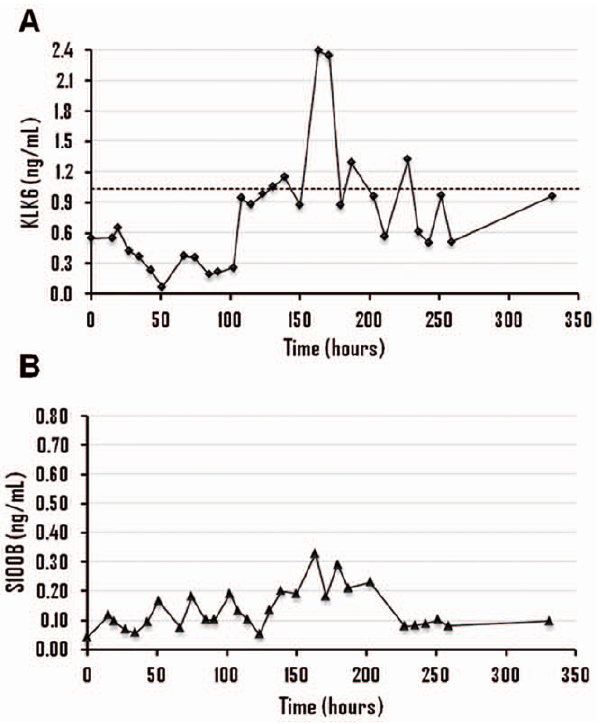
Figure 4. Time evolution of kallikrein 6 (A) and S100B levels (B), in ng/mL, for patient 2.